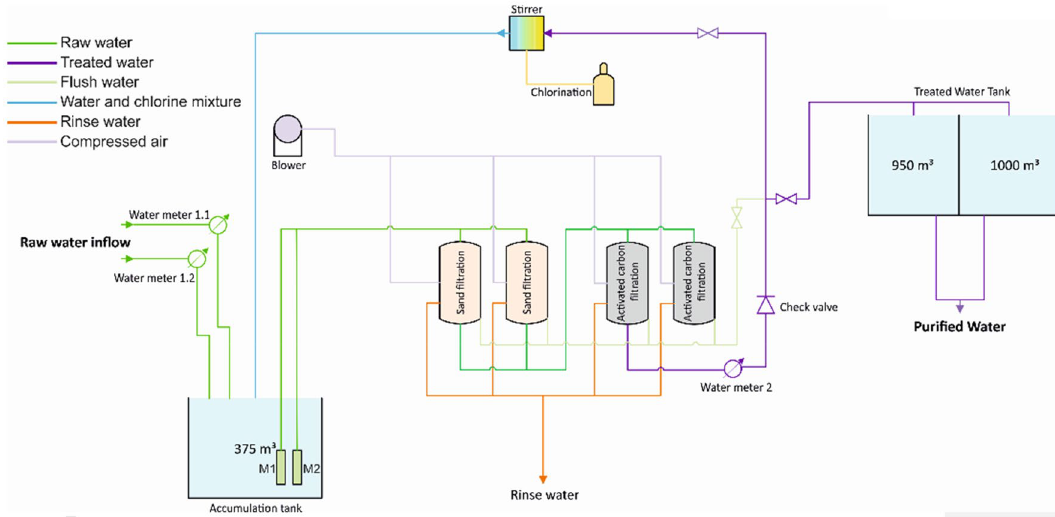
Figure 5. Scheme of the water filtration system.